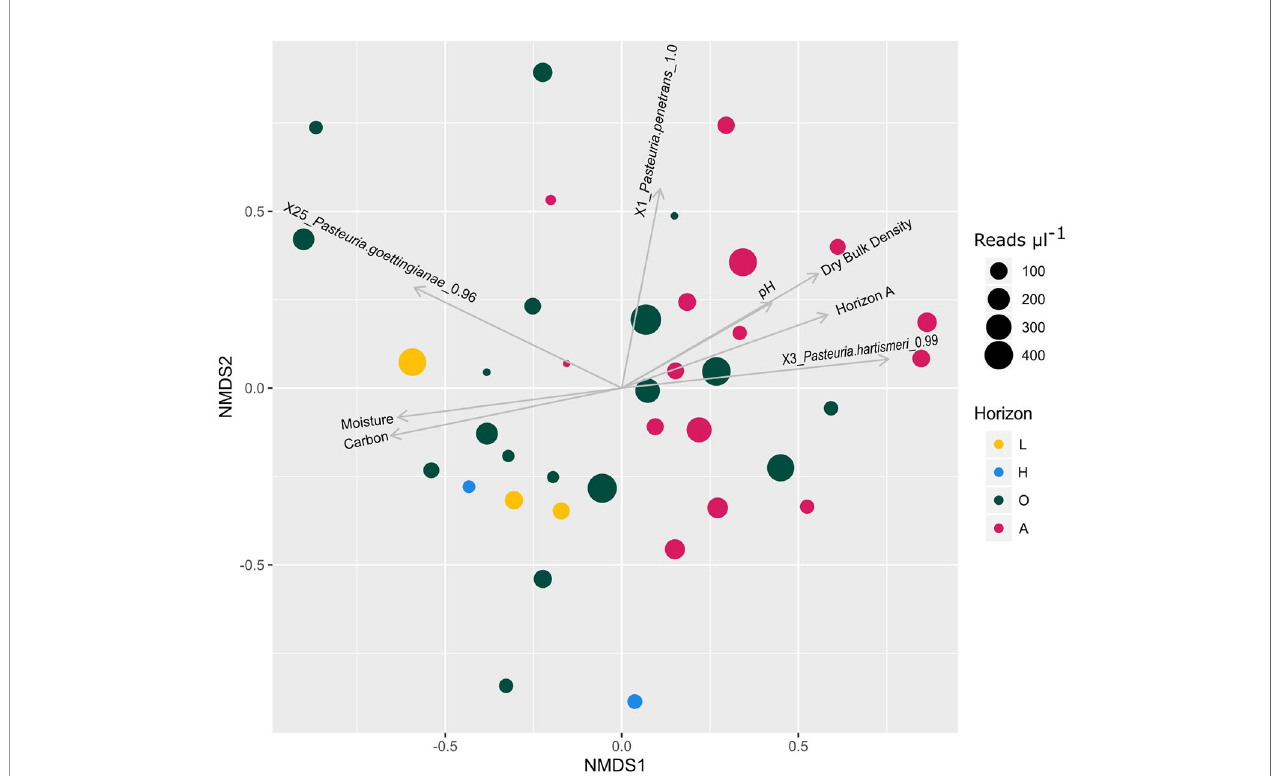
FIGURE 4 | NDMS ordination plot of NSIS2 Pasteuria spp. community composition. Points are colored by soil horizon where L = litter; H = humus; O = peaty material formed under wet, anaerobic conditions; and A = mineral horizon formed at or near the surface showing accumulation and incorporation of organic matter. Points are sized by the total number of merged read pairs µl − 1 of PCR product added to the fi nal pool from the corresponding sample. Stress = 0.245235.